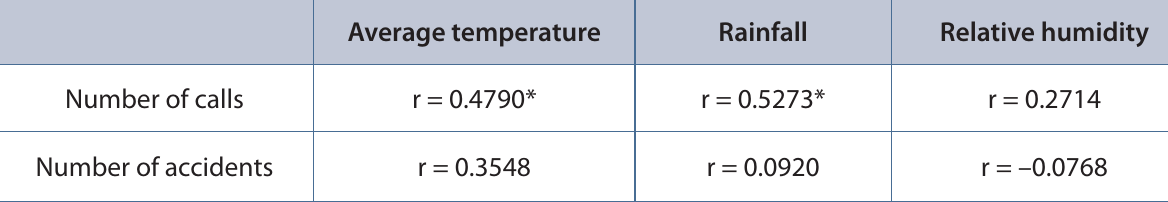
Table 1. Correlation between the number of calls and the number of accidents with climate conditions Average temperature Rainfall Relative humidity Number of calls r = 0.4790* r = 0.5273* r = 0.2714 Number of accidents r = 0.3548 r = 0.0920 r = –0.0768 *significance level is